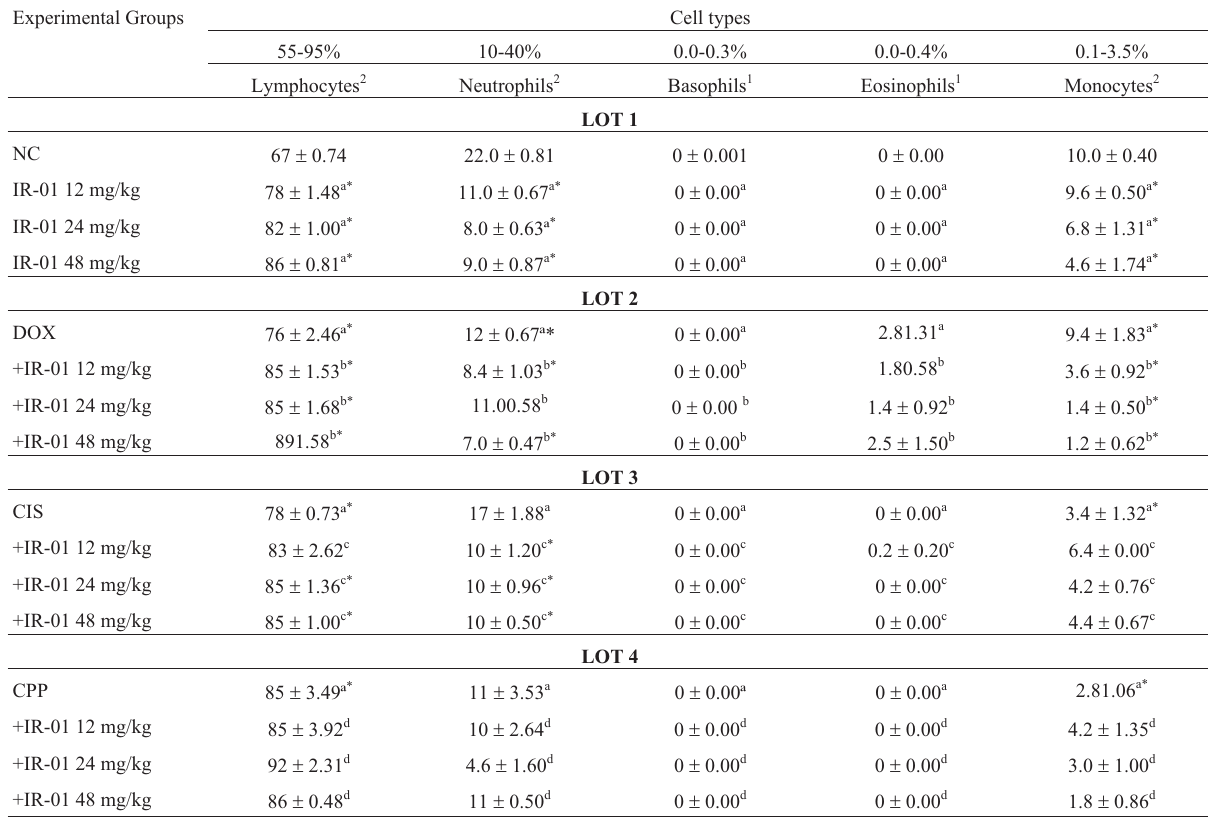
Table 4 - Reference values and results related to the differential blood cell